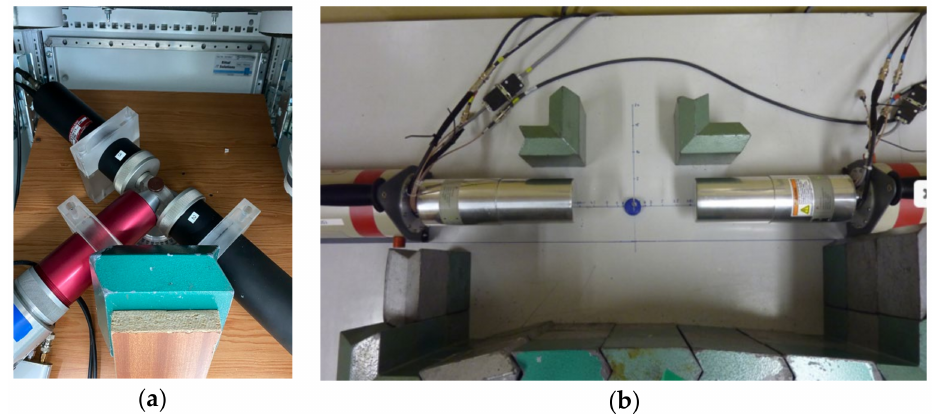
Figure 3. Air-conditioned unit setup for PALS ( a ) and CDB instrument in Institute of Nuclear and Physical Engineering, Bratislava ( b